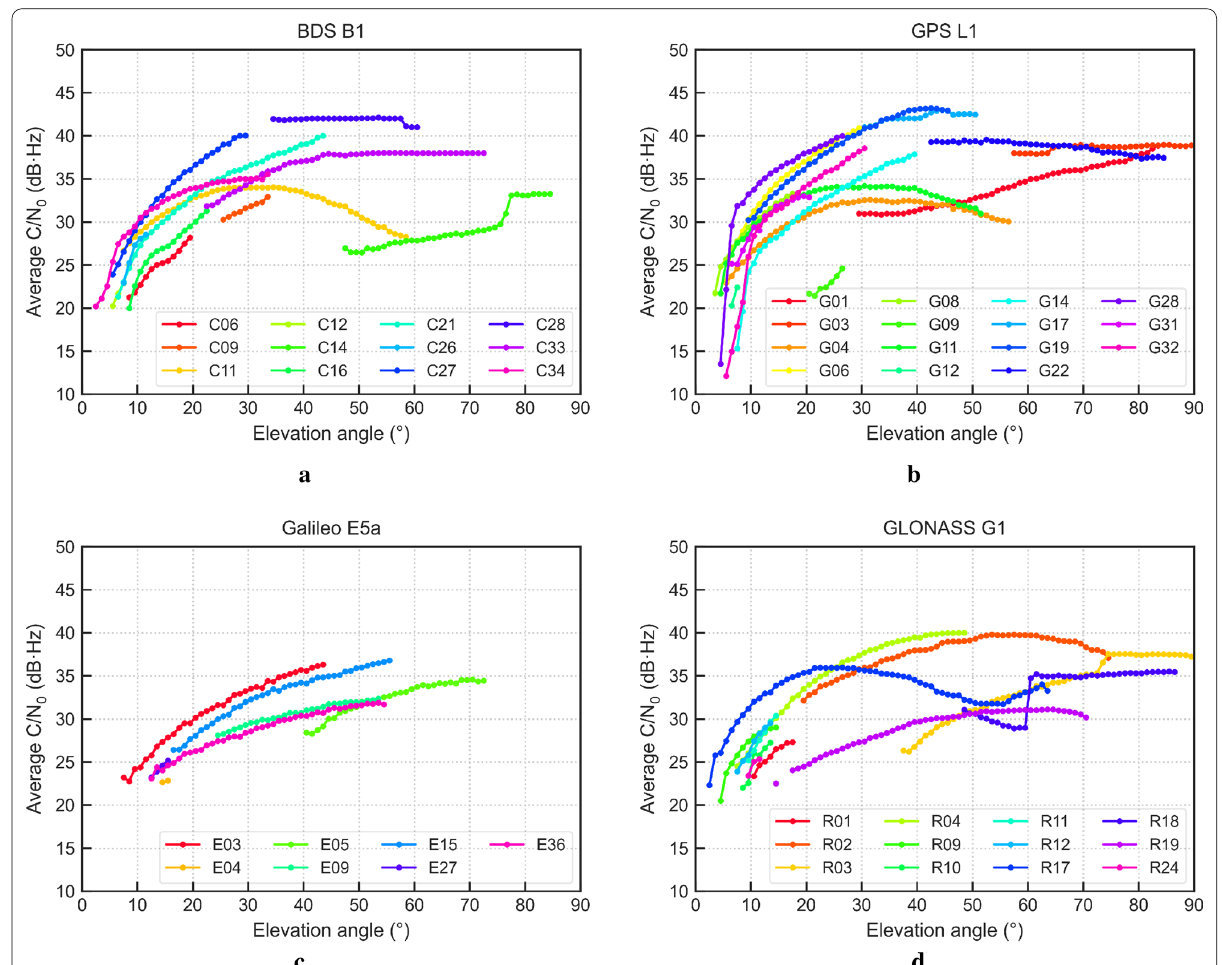
Fig. 8 Average C/N0 versus the elevation angles of the observed satellites on a BDS B1, b GPS L1, c Galileo E5a and d GLONASS G1